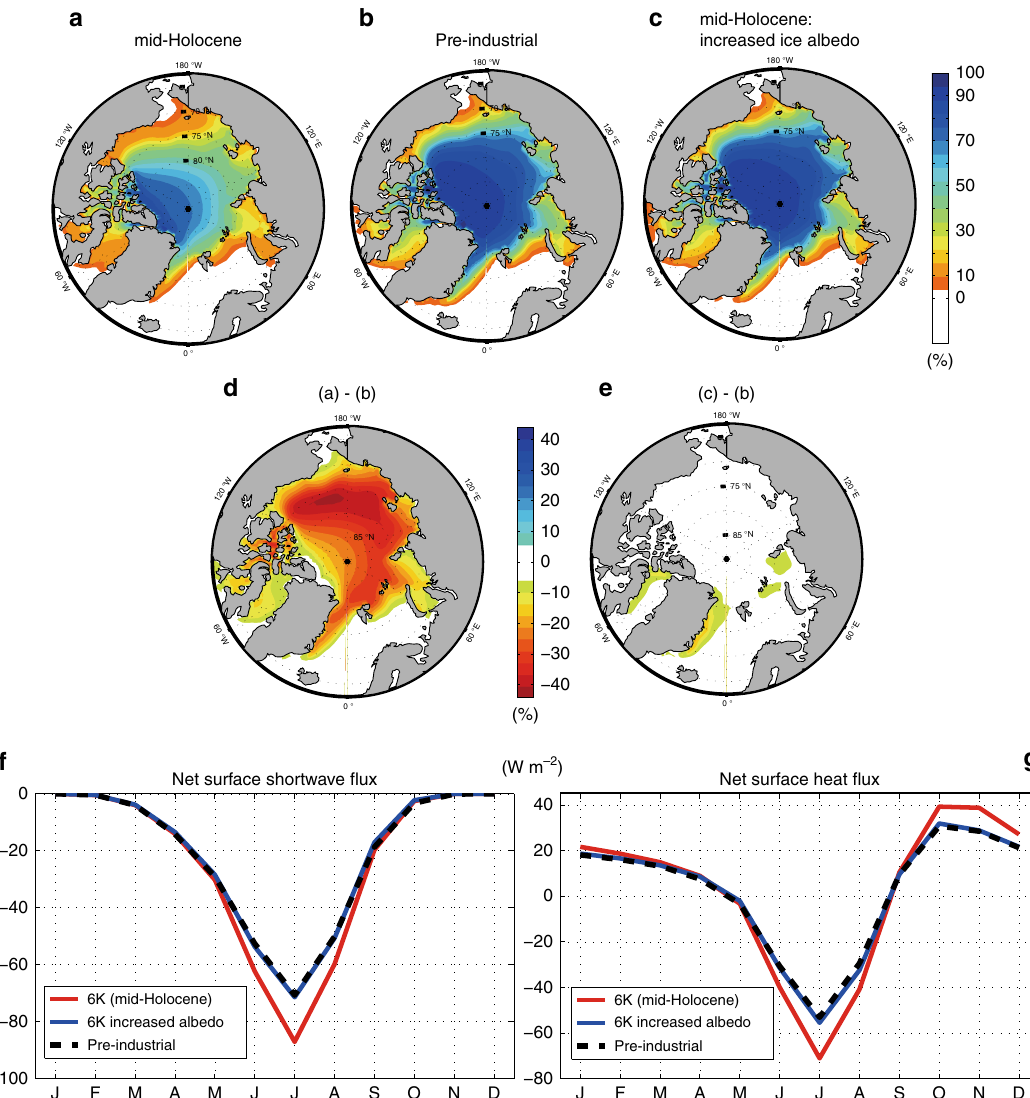
Fig. 1 Simulated Arctic sea ice concentration and surface heat fl ux. Arctic sea ice concentration (%) in Jul – Nov from simulations of a mid-Holocene climate, b pre-industrial climate, and c mid-Holocene climate with pre-industrial sea ice concentration (imposed via increased ice albedo). Jul – Nov averaged sea ice concentration differences d between the mid-Holocene and pre-industrial simulations, i.e. a – b , and e between the mid-Holocene simulation with pre- industrial sea ice and the pre-industrial simulation, i.e. c – b . The seasonal cycle of f net surface shortwave fl ux ( F SW ↑ − F SW ↓ ) and g net surface heat fl ux with pre-industrial sea ice, and pre-industrial simulations,